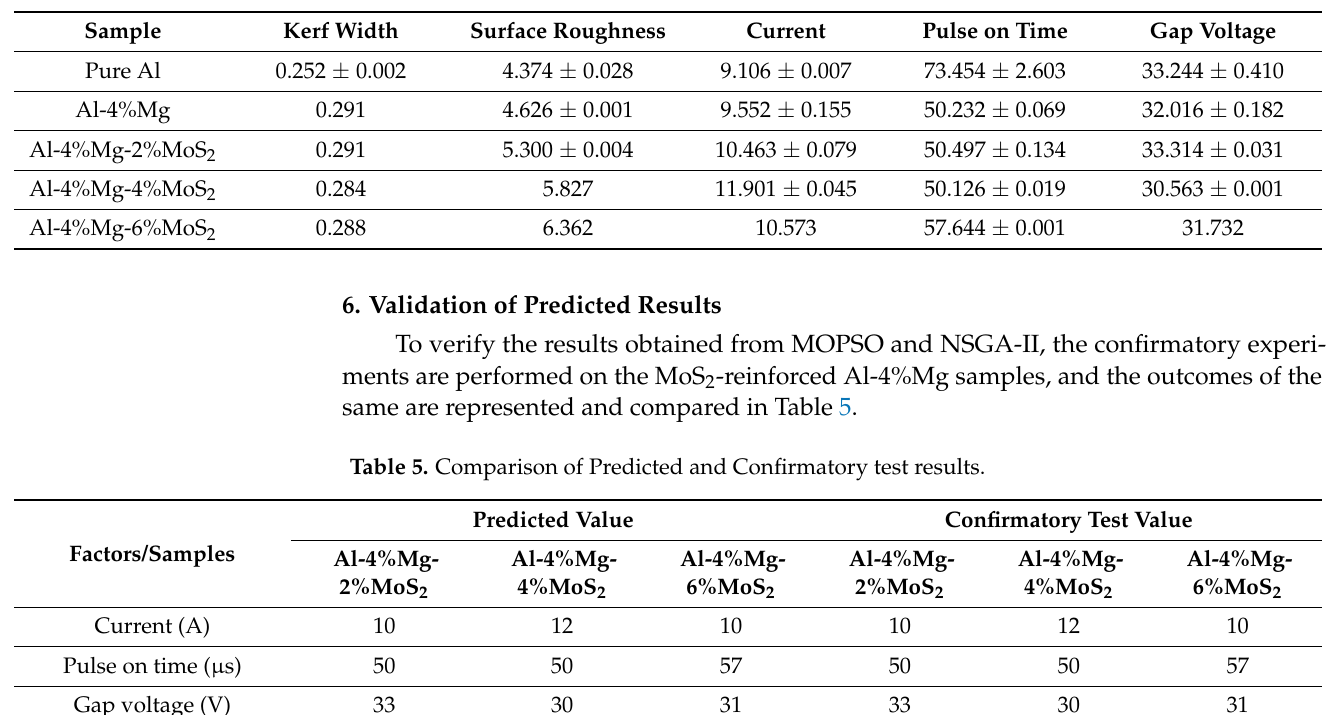
Table 4. Machining parameters range obtained using MOPSO.